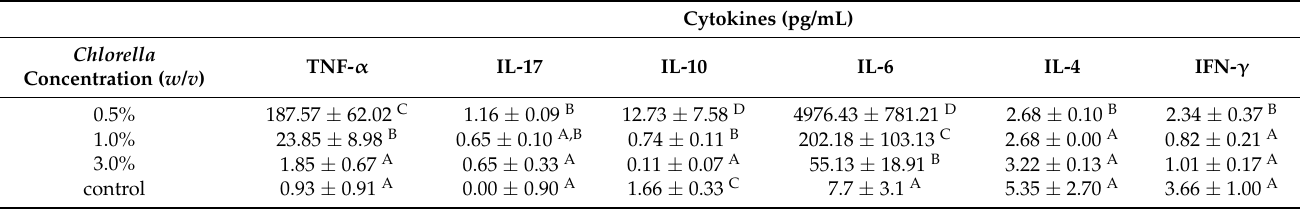
Table 4. Cytokine production by mononuclear